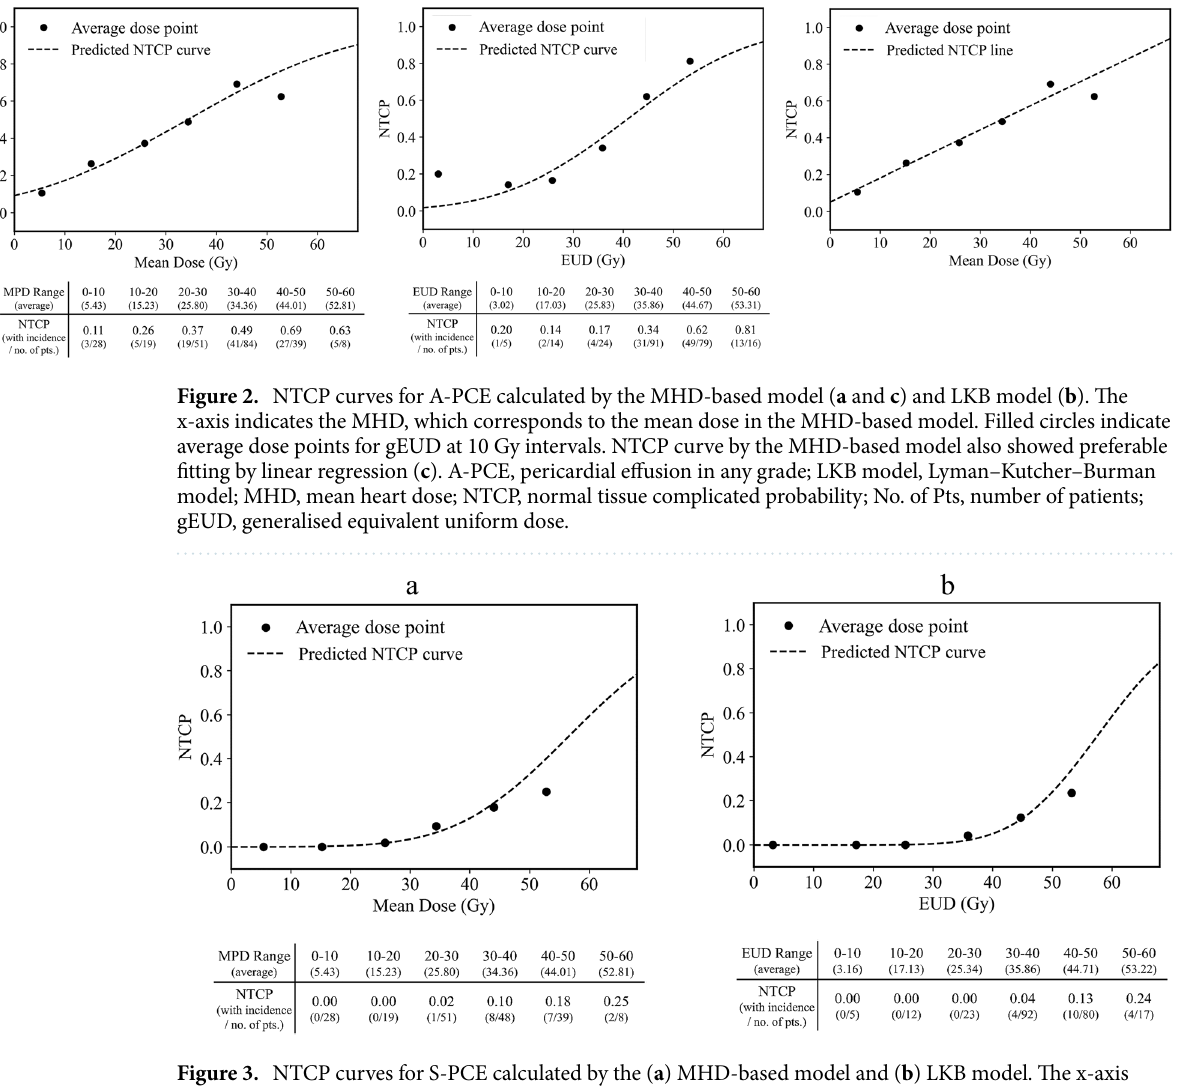
Figure 3. NTCP curves for S-PCE calculated by the ( a ) MHD-based model and ( b ) LKB model. The x-axis indicates gEUD, which corresponds to the mean dose in the MHD-based model. Filled circles indicate average dose points for gEUD at 10 Gy intervals. gEUD, generalised equivalent uniform dose; LKB model, Lyman– Kutcher–Burman model; No. of Pts, number of patients; NTCP, normal tissue complicated probability; S-PCE, symptomatic pericardial effusion; MHD, mean heart